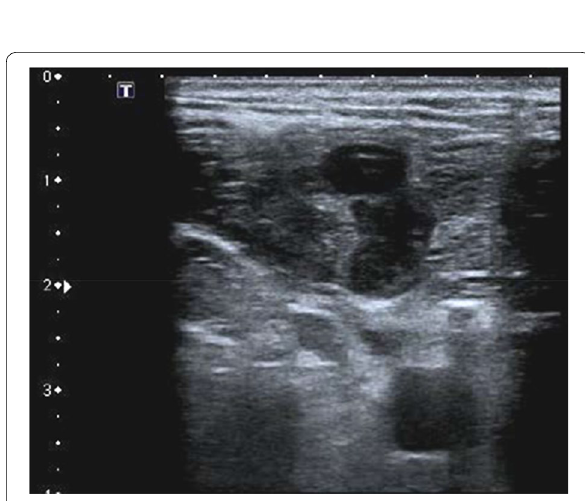
Fig. 3 Soft tissue hematoma of the left side of the neck. No